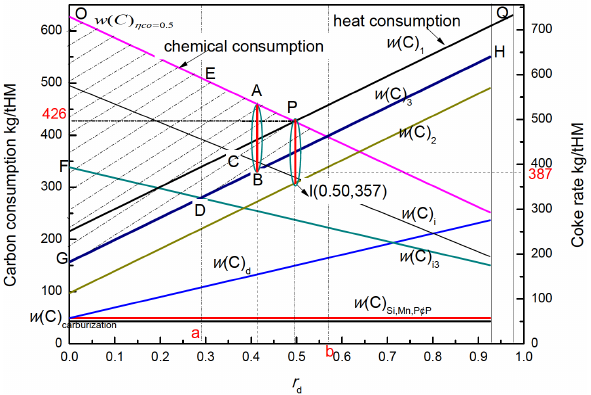
Figure 2: Carbon consumption in different